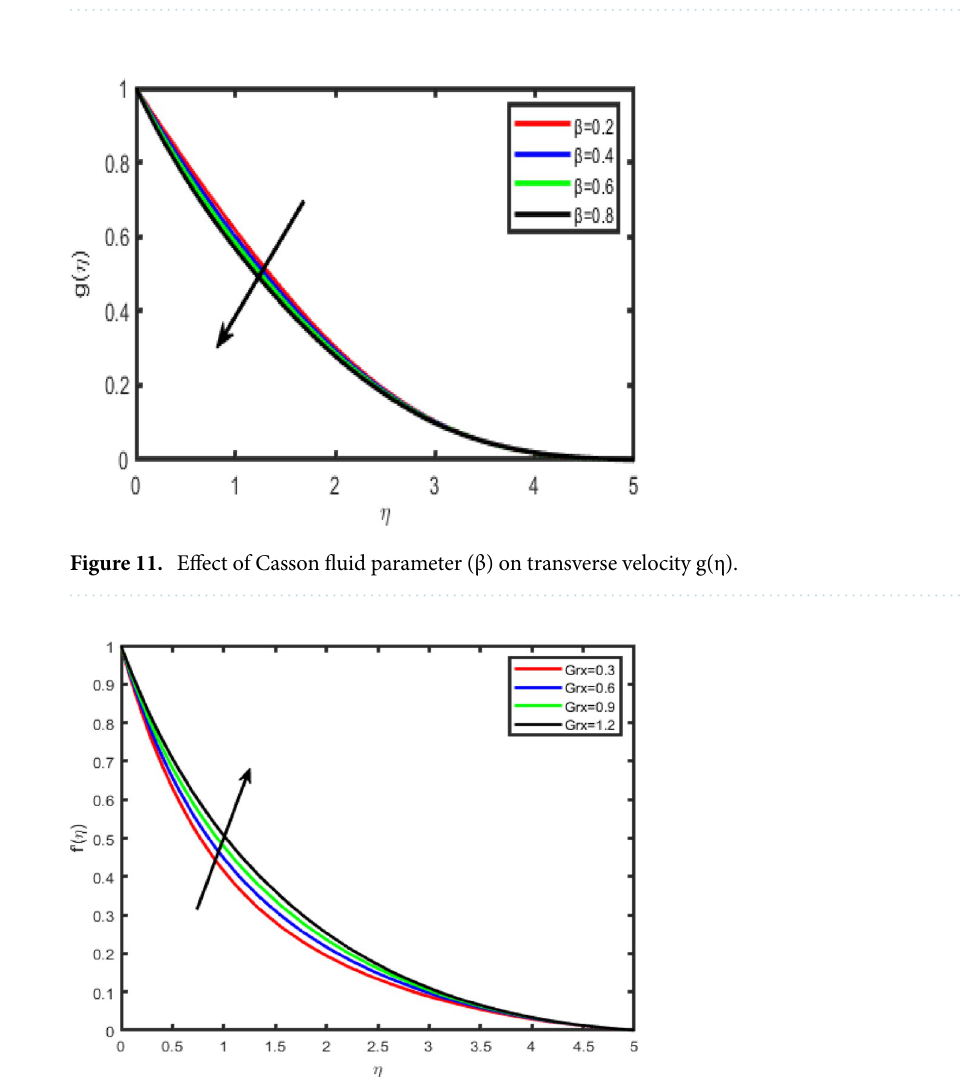
Figure 10. Effect of Casson fluid parameter (β) on tangential velocity f ′ (η).